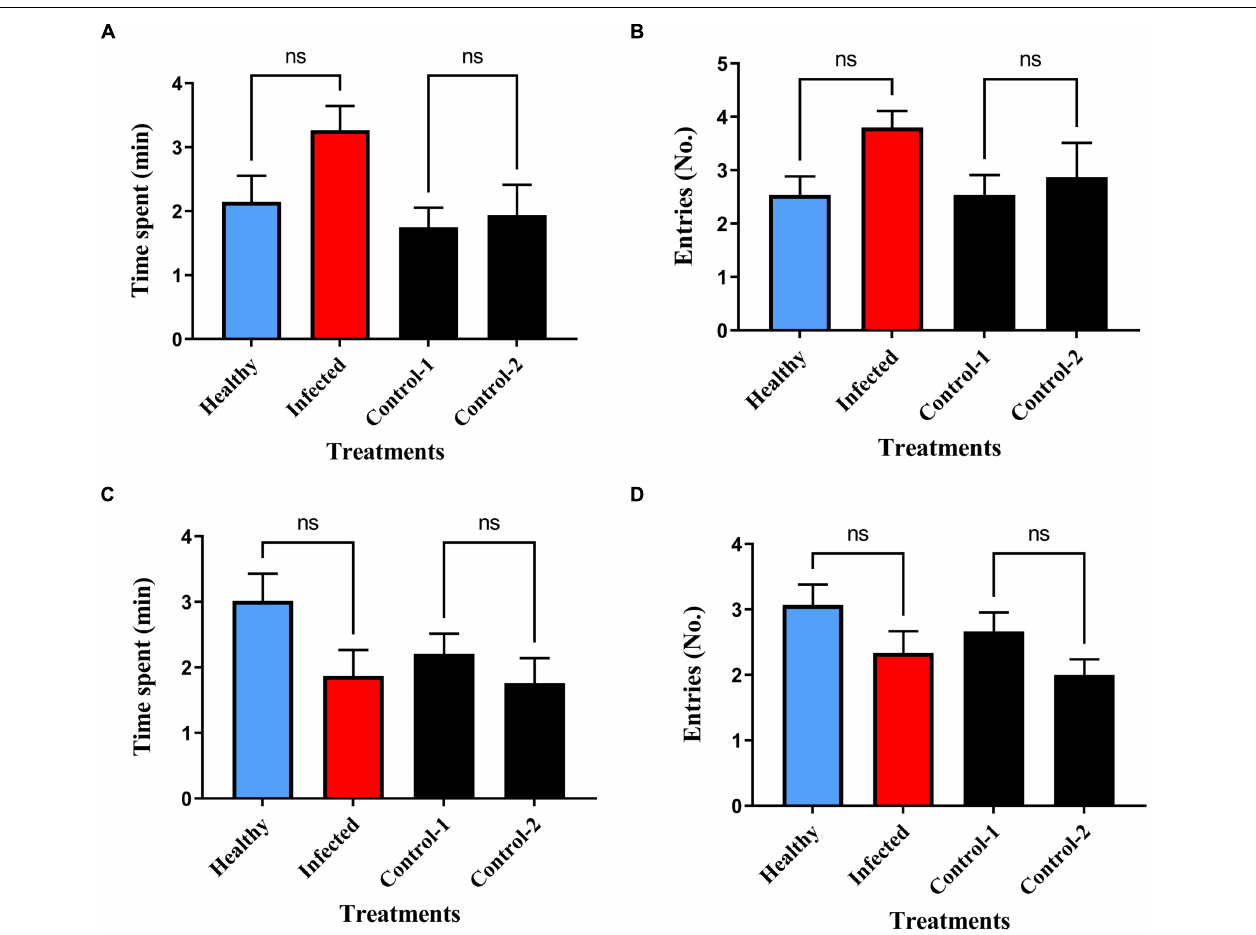
FIGURE 2 | Behavioral response of B. tabaci to chili plant volatiles in olfactometer bioassays (A,B) non-viruliferous males to healthy (blue bars) and ChLCV infected plant (red bars) volatiles. (C,D) Viruliferous males to healthy and ChLCV infected plant volatiles. ns = non-significant.